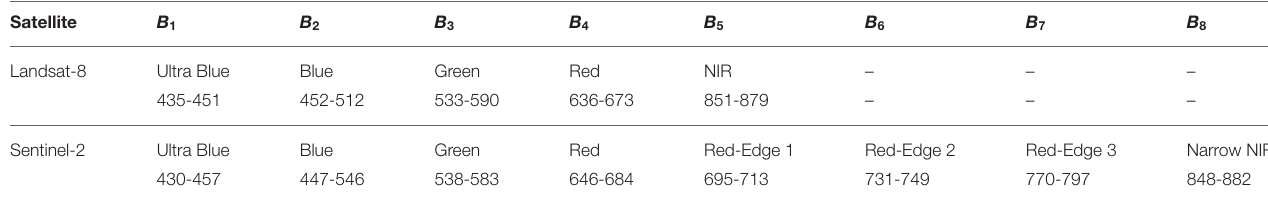
TABLE 2 | Convolved hyperspectral wavelengths (nm) to match Landsat-8 OLI (L8) and Sentinel-2 MSI (S2) bands (B). Satellite B